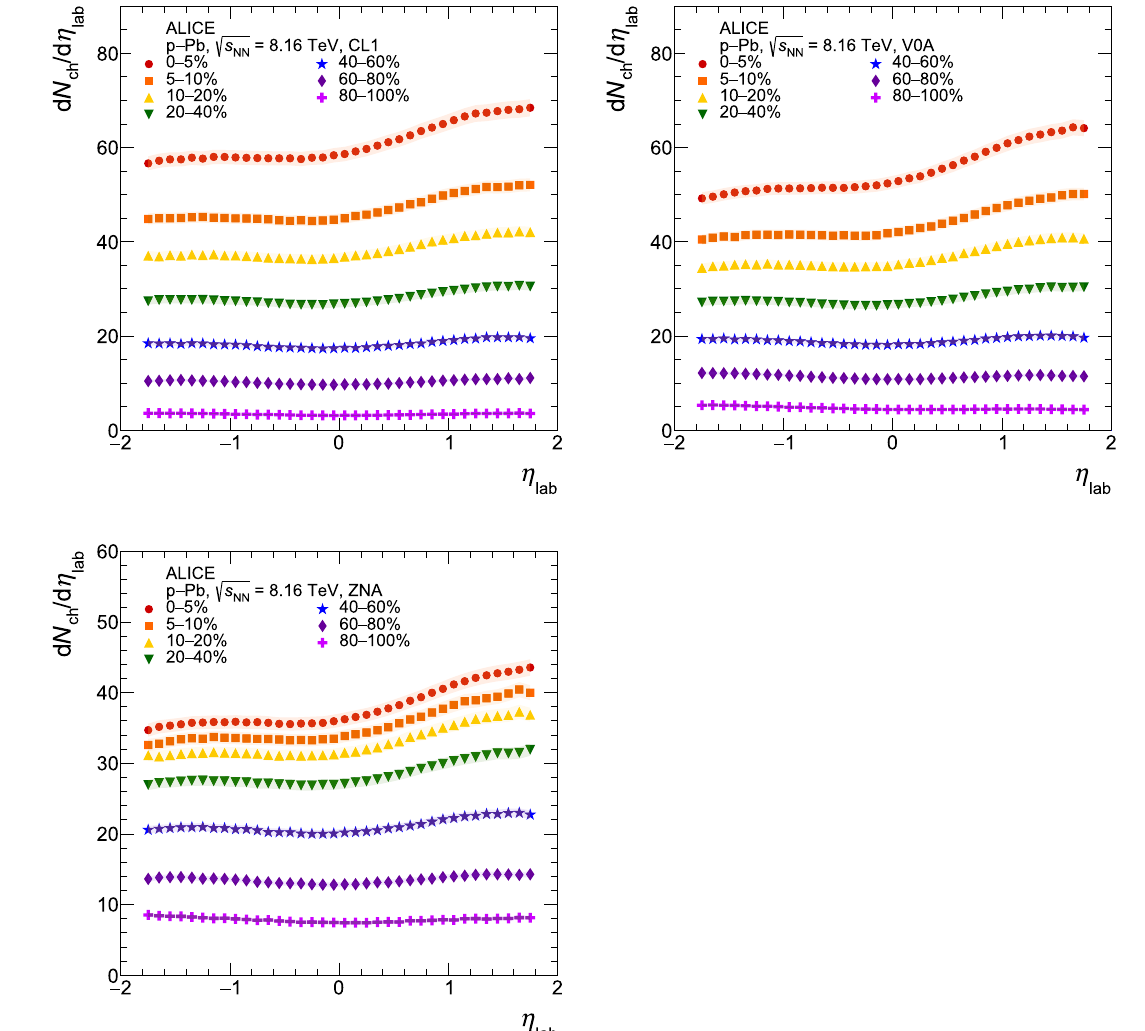
√ = 8 . 16 TeV for various centrality classes and estimators: CL1 s NN